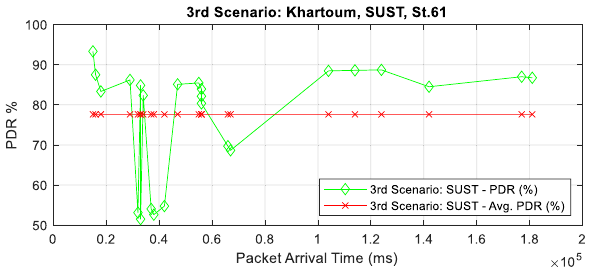
Fig. 8 PDR and received packets as a function of time (3rd